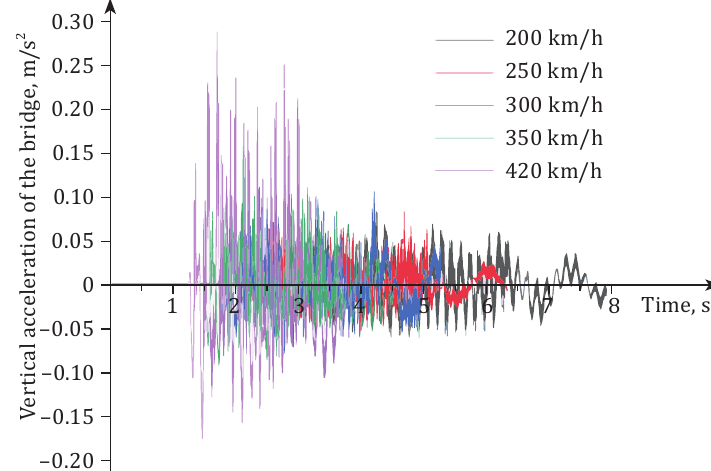
Figure 20. Comparison of vertical acceleration time history at bridge midspan